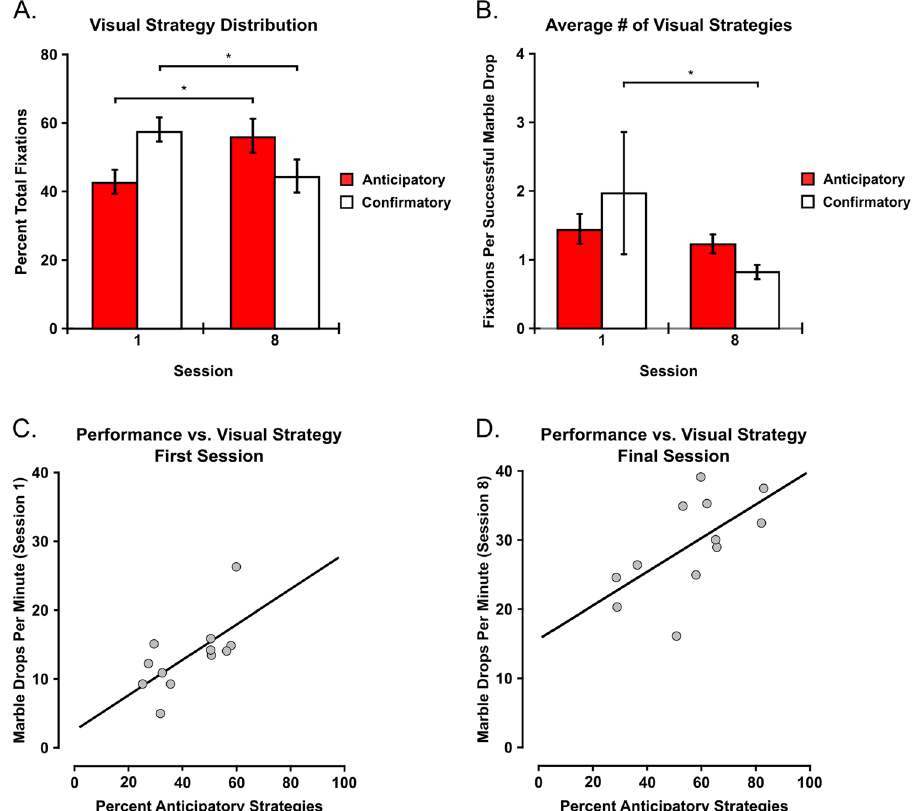
Figure 3. Visual Strategies and Behavioral Performance. ( A ) Visual Strategy Distribution. During the first behavioral training session, confirmatory visual strategies were more prominent than anticipatory strategies. This distribution was reversed during the final training session. ( B ) Average number of visual strategies per successful marble drop between the first and final training sessions. Significantly fewer confirmatory visual strategies per successful marble drop were observed after training. ( C , D ) Associations between anticipatory strategy distributions and behavioral performance for the first ( C ) and final ( D ) training sessions. * Denotes significance at the 0.05 level. Error bars indicate SEM. N = 12. Correlations computed using Spearman’s